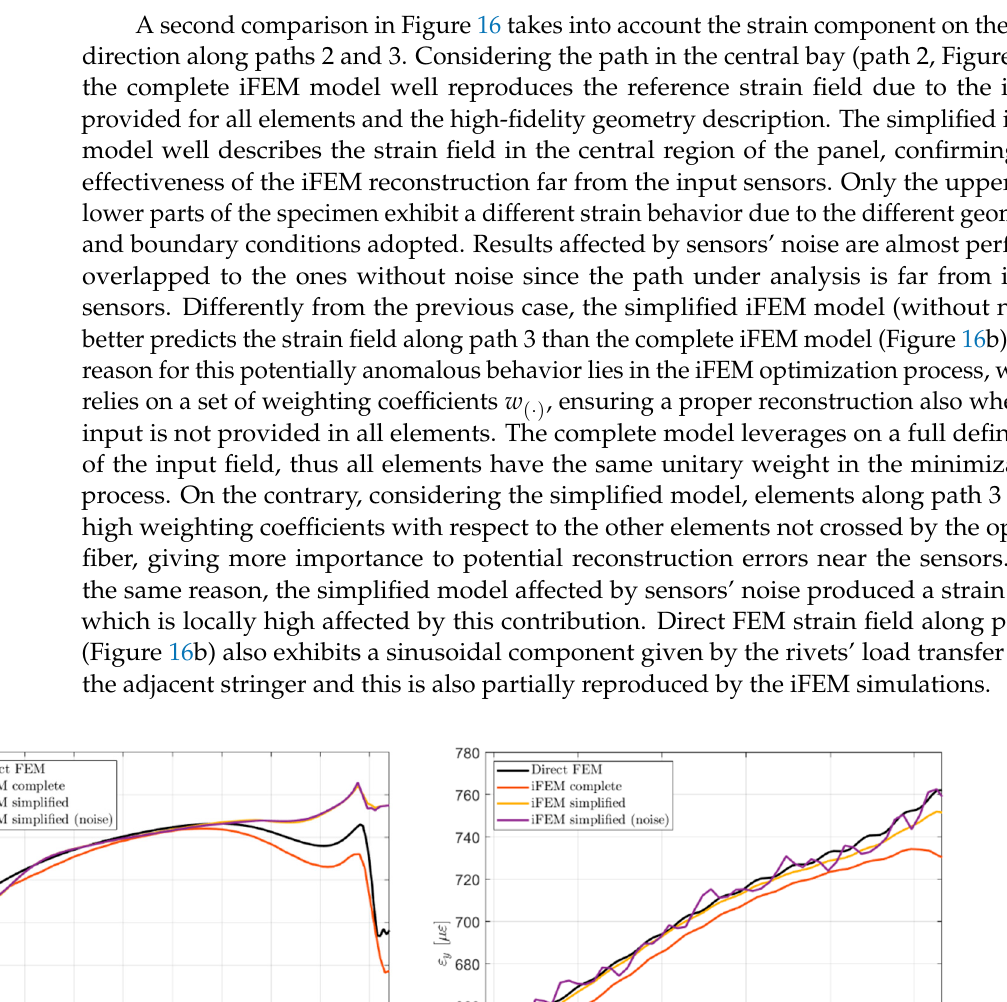
Figure 16. Vertical strain component 𝜀 (cid:3052) comparison on the top side of the structure: ( a ) Path 2; ( b ) Path 3. Table 5. Comparison between maximum displacement results.